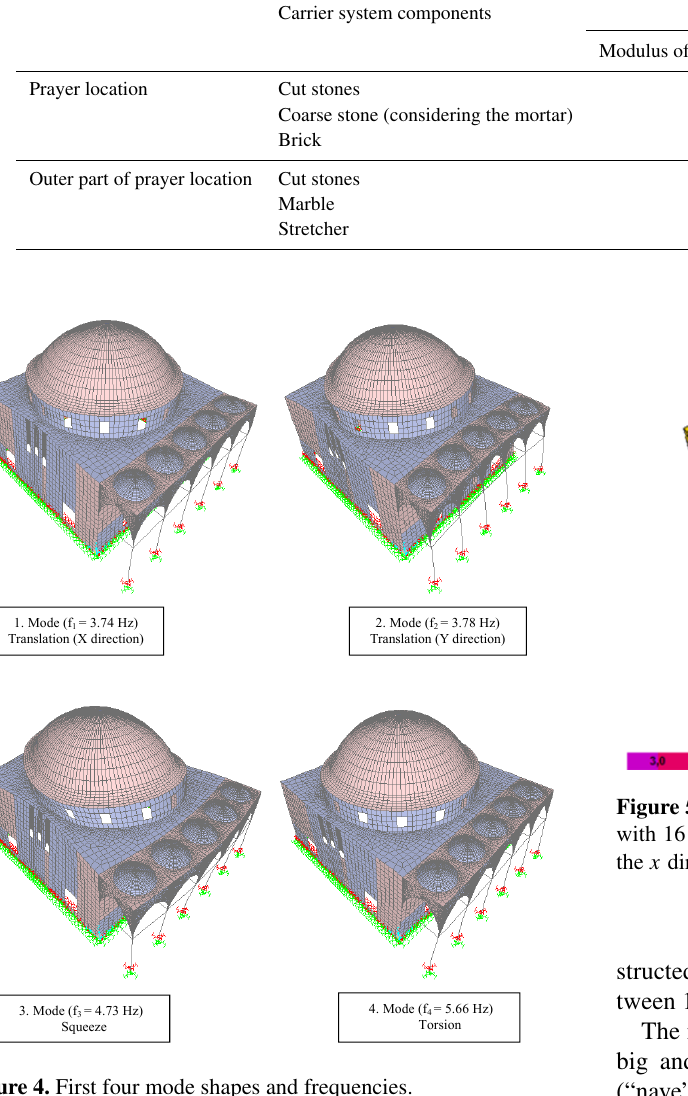
Figure 4. First four mode shapes and frequencies.